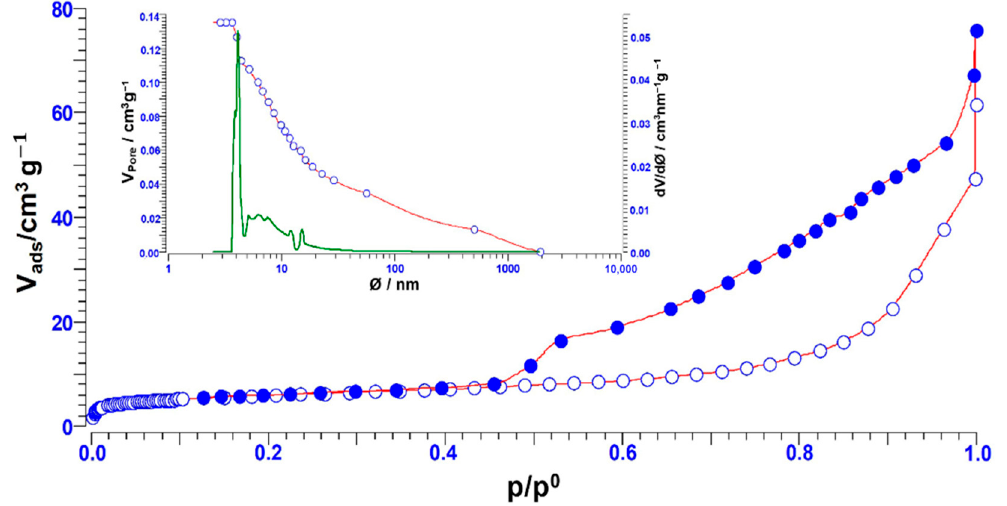
Figure 3. N 2 adsorption/desorption isotherm of Na clays.